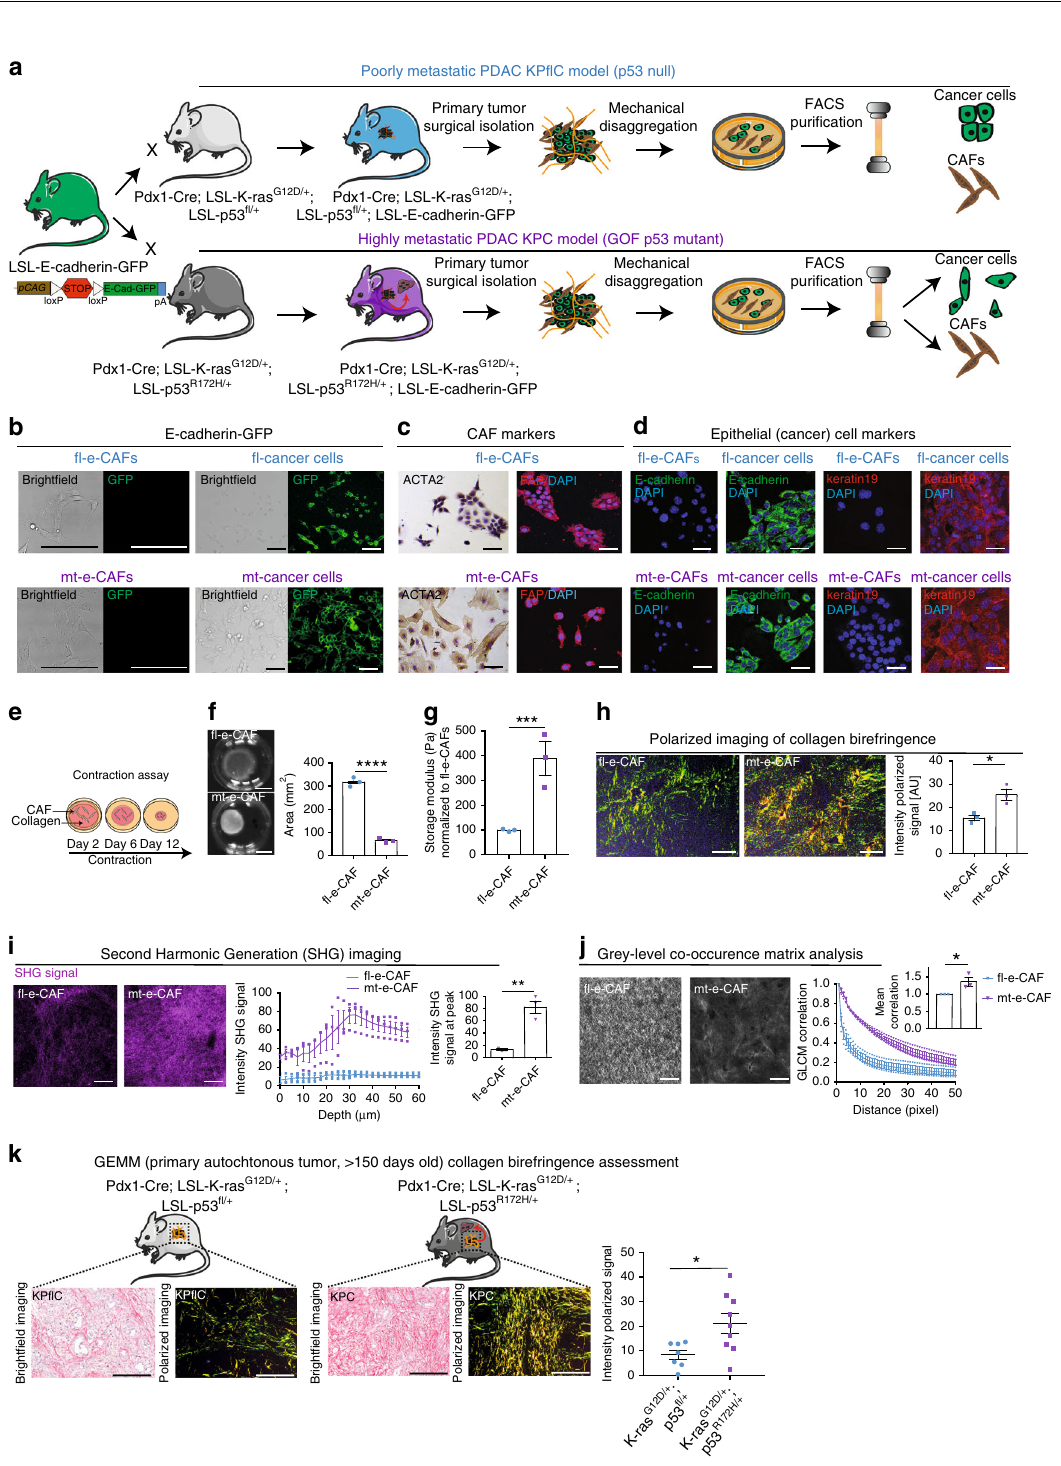
conditioned media (CM) generated by fl -e-CAFs, mt-e-CAFs, fl -CCs, or mt-CCs. fl -e-CAF matrices demonstrated an increase in fi brillar collagen density upon treatment with CM generated by mt-e-CAFs or by mt-CCs compared to CM generated by fl -e- CAFs or by fl -CCs (Fig. 2b). Conversely, treating mt-e-CAF matrices with CM generated by fl -e-CAFs, fl -CCs or mt-CCs did not signi fi cantly alter collagen birefringence compared to treatment with CM generated by mt-e-CAFs (Fig. 2c). This suggests that factors secreted by mt-e-CAFs or by mt-CCs can potentiate fl -e-CAFs to increase matrix remodeling.